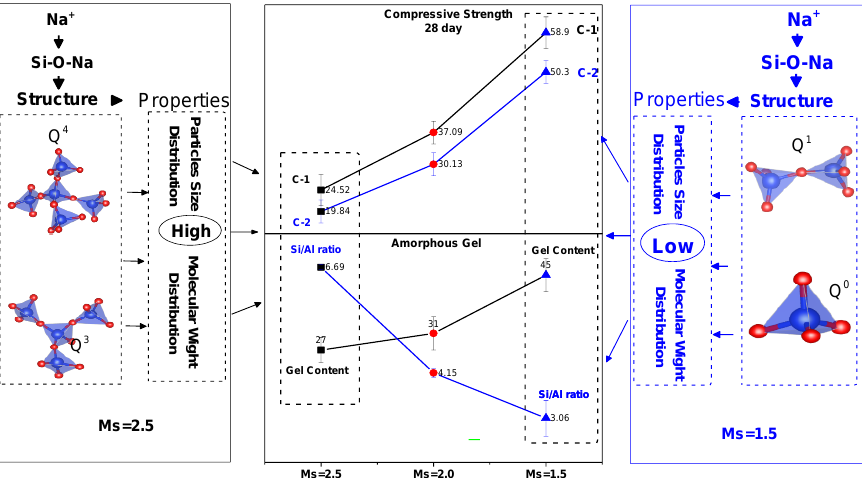
Figure 15. Relationship between waterglass properties, gel content and compressive strength.